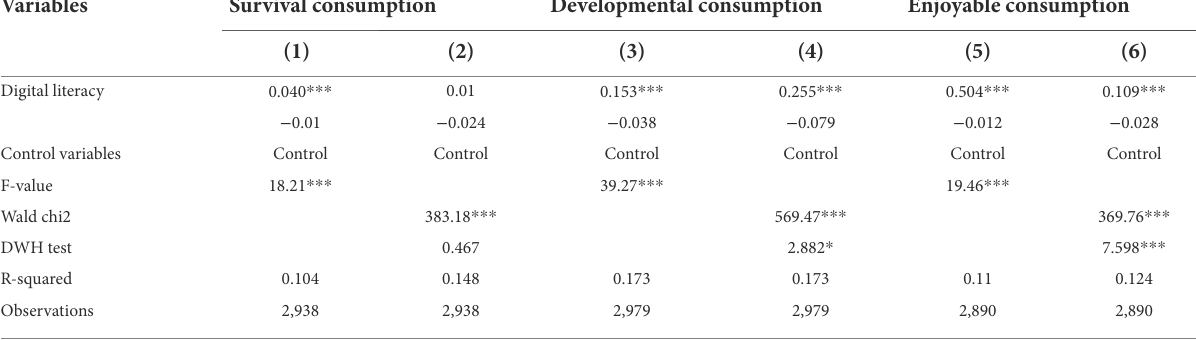
TABLE 7 Estimation results of how digital literacy affects consumption structure.